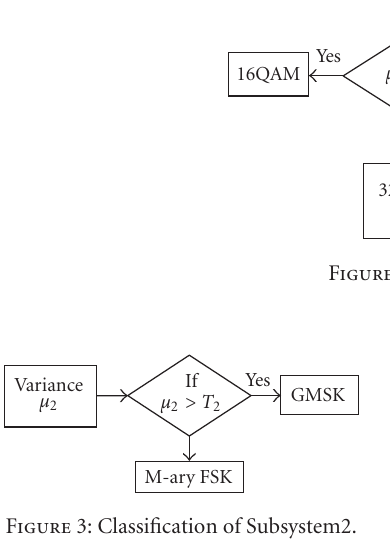
Figure 3: Classification of